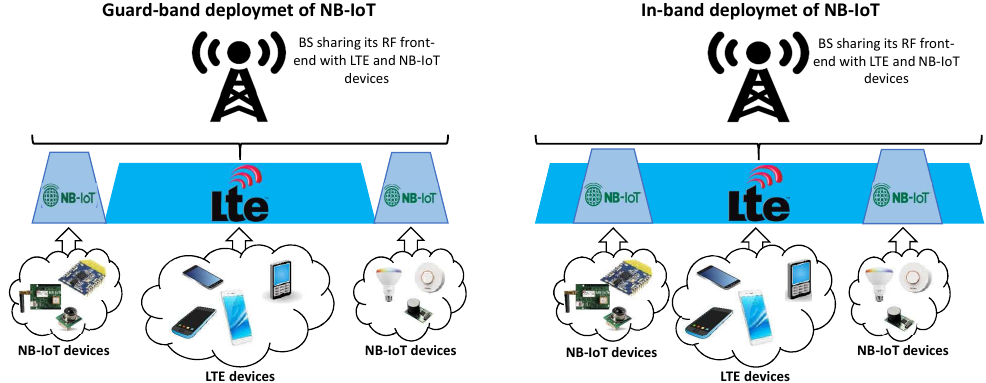
Figure 7. Application of the proposed hypervisor where a single BS serves both LTE and NB-IoT